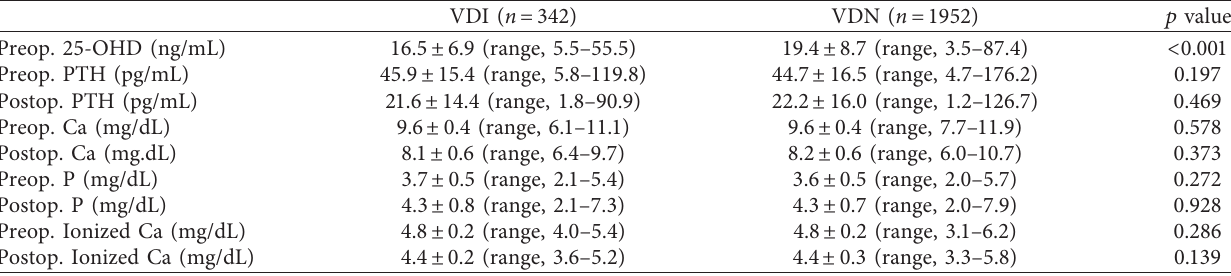
Table 2: Comparison of perioperative biochemical characteristics between vitamin D3 injection (VDI) and vitamin D3 noninjection (VDN)